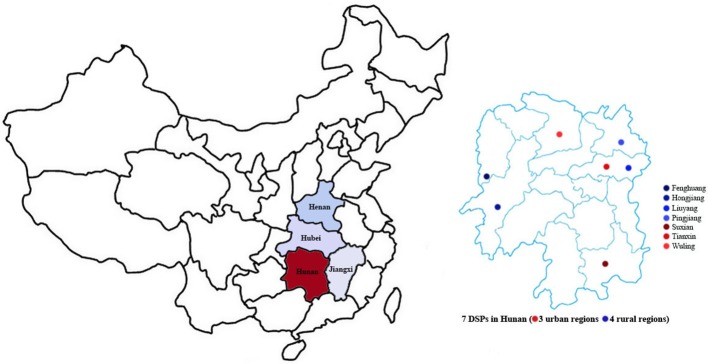
Central China (including Hunan, Jiangxi, Hubei, and Henan) and 7 DSPs in Hunan Province (3 urban regions and 4 rural regions).